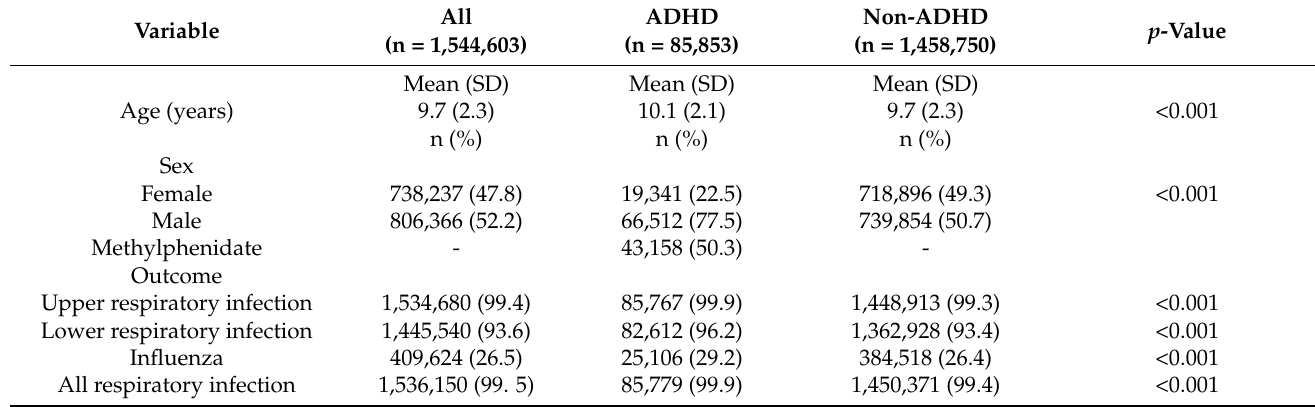
Demographics and respiratory infections of children and adolescents with and without attention- deficit/hyperactivity